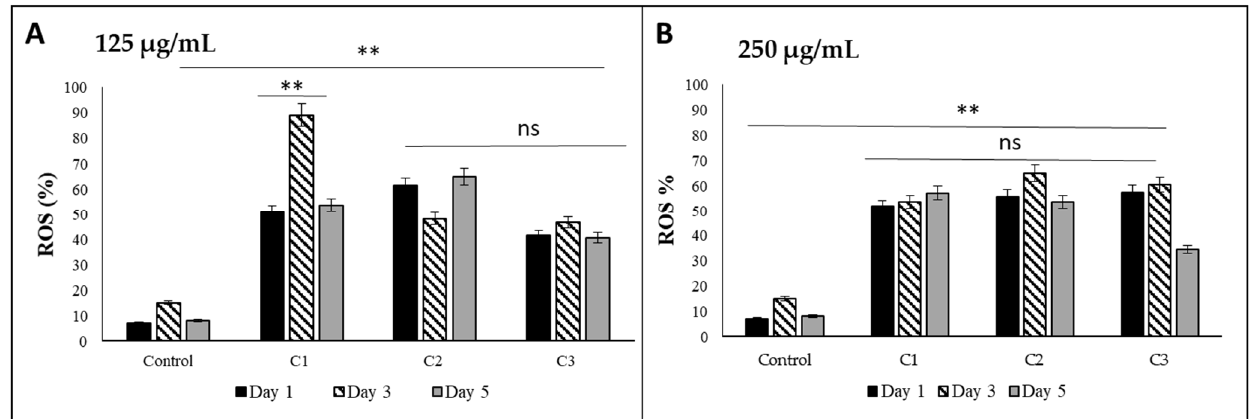
Figure 9. ROS production in gingival human fibroblasts after incubation for 1, 3, and 5 days with the newly synthesized nanomaterials in different concentrations (( A ) 125 and ( B ) 250 µg/mL). ( p < 0.01 **).